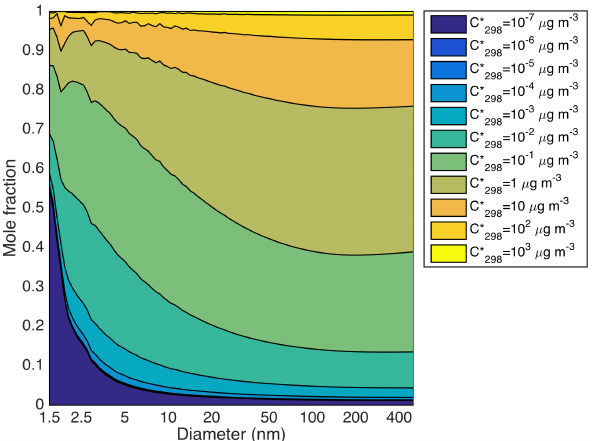
Figure 9. Modelled SOA volatility distribution as a function of the particle size from a simulation with the 2-D VBS and ELVOC for- mation from ozonolysis and OH-oxidation of monoterpenes and sesquiterpenes (Reactions R1 and R2). The results are from Day 3 after 5h into the UV light